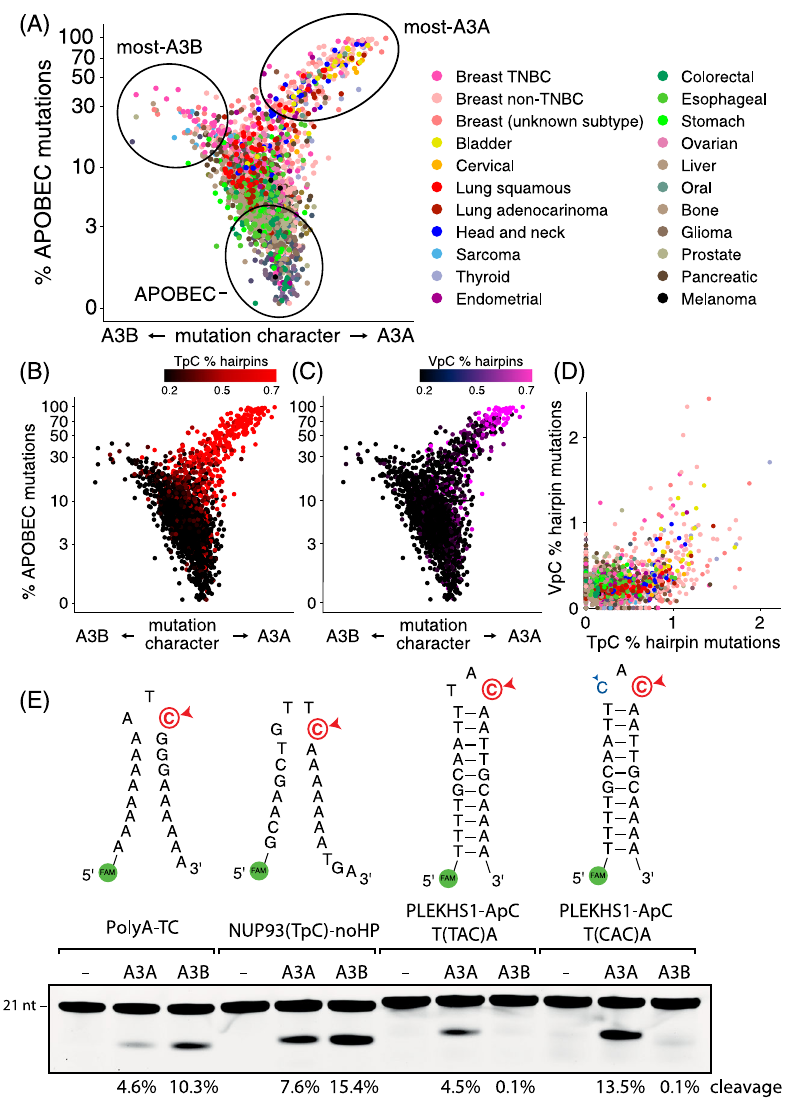
Fig. 3 Hairpin mutations at VpC sites and TpC sites are caused by APOBEC3A not APOBEC3B. A A set of tumors sequenced by WGS was strati fi ed by two parameters: the y -axis separates APOBEC − tumors (bottom) from APOBEC + tumors (top), and the x -axis separates tumors with high A3B character (left) from those with high A3A character (right). Points are colored by tumor type (legend at right). B When tumors are colored by the fraction of APOBEC mutations occurring in TpC hairpins, it is clear that tumors enriched for TpC hairpin mutations (red) tend to be A3A-dominated APOBEC + samples. C When tumors are colored by the fraction of APOBEC mutations occurring in VpC hairpins, the same pattern is evident: tumors with the highest levels of VpC hairpin mutations (magenta) tend to be A3A-dominated tumors. D TpC and VpC hairpin mutations are tightly associated: tumors enriched for one are enriched for both, suggesting that A3A is the joint cause of both. E Comparison of A3A and A3B activity on DNA oligos representing non- hairpin TpC sites and hairpin VpC sites. A3A activity is seen on all substrates, but A3B activity is not observed at VpC sites. Source data are provided as a Source Data fi